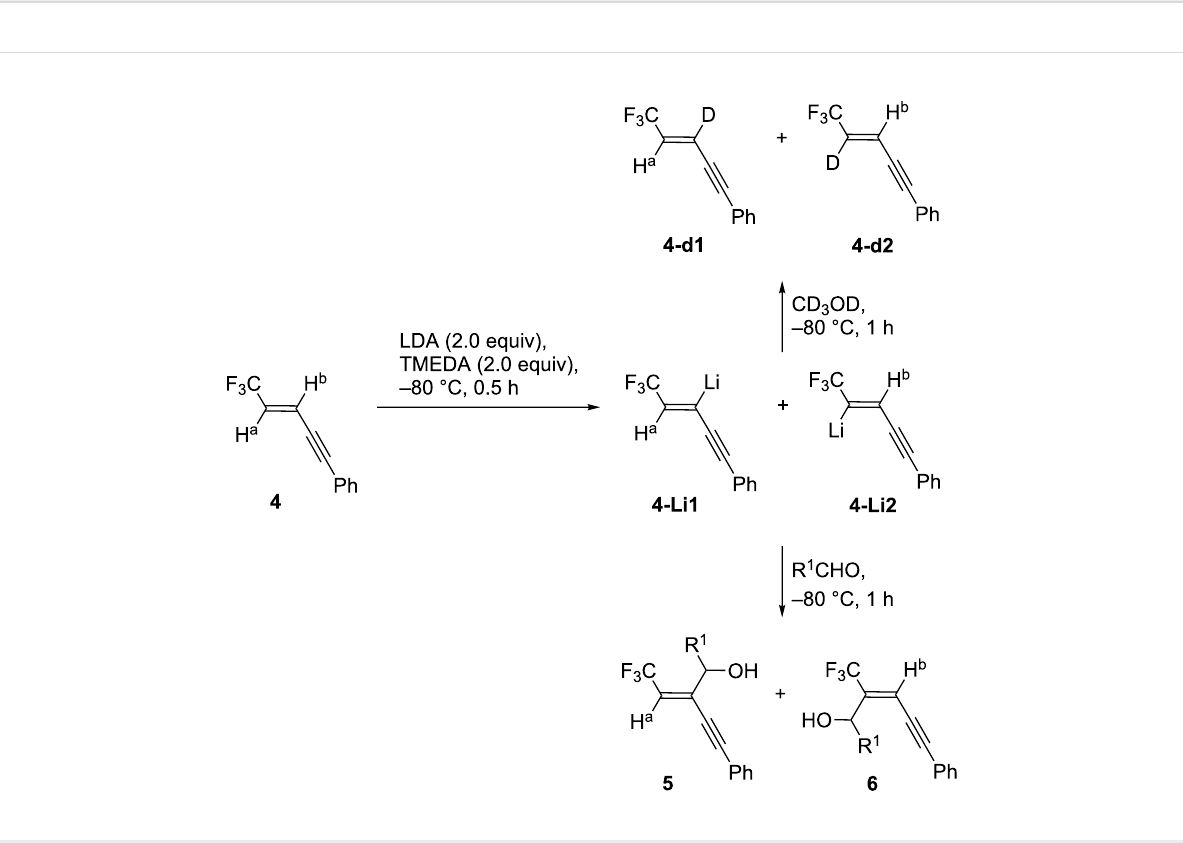
Scheme 4: Lithiation of 4 and the following electrophilic